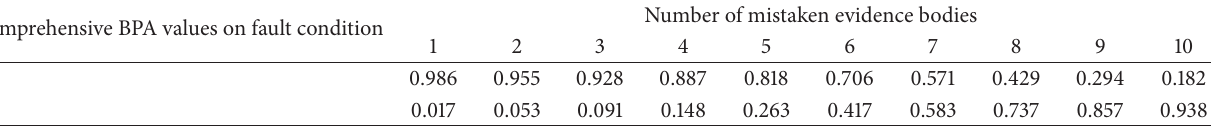
Table 4: WABP performance under mistaken condition A when a fault occurs on 𝐿 1 .